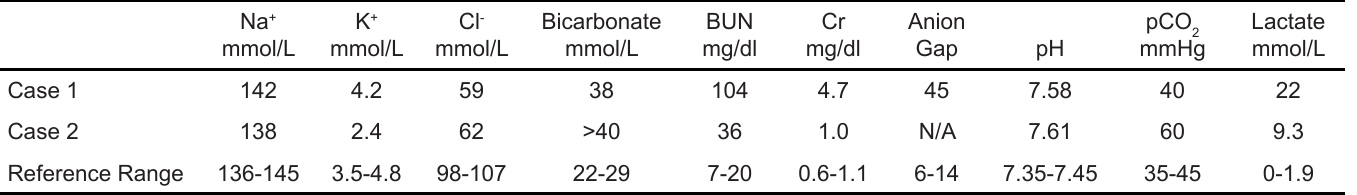
Table. Case 1: Initial laboratory studies of patient with hepatocellular carcinoma. Case 2: Initial laboratory studies of patient presenting with altered mental